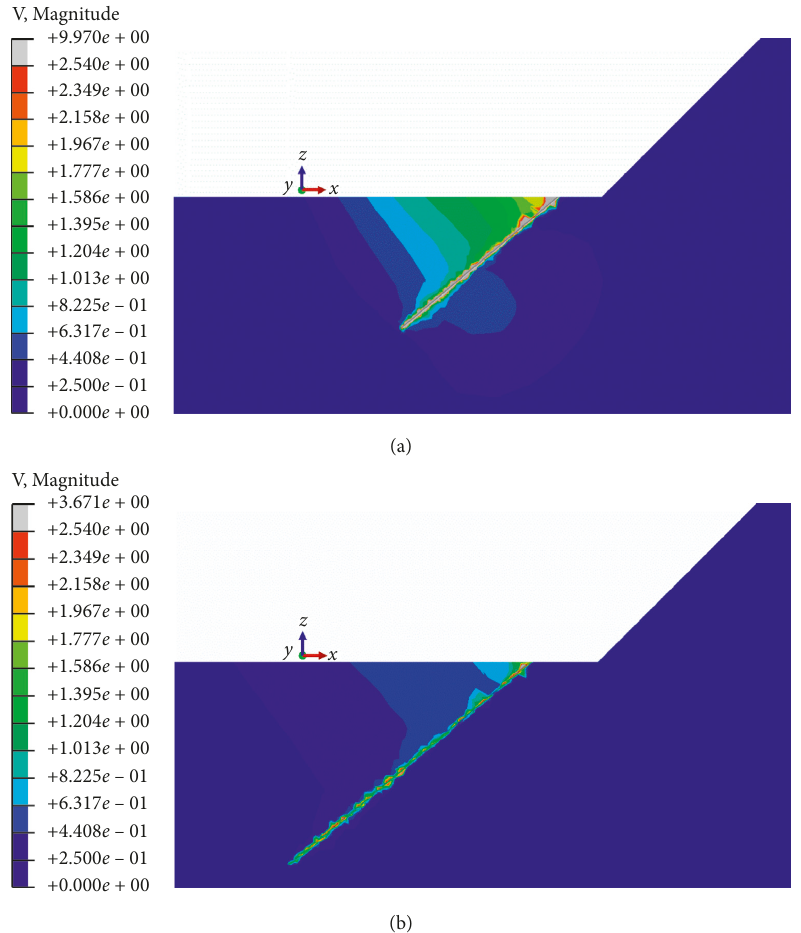
Figure 9: Contours of blasting vibration velocity at 2ms under different charging conditions. Blasting load: (a) 1620MPa and (b) 727.1MPa.